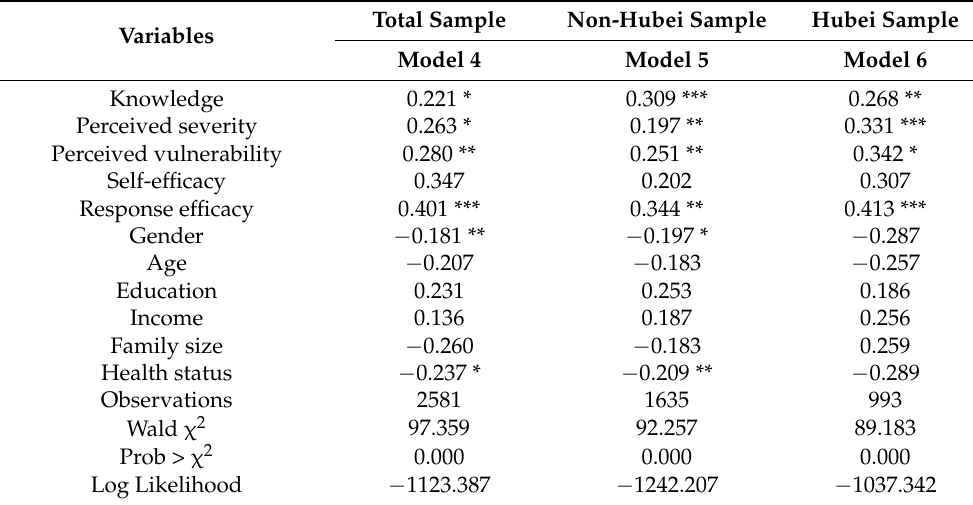
Table 10. Determinants of residents’ WTP